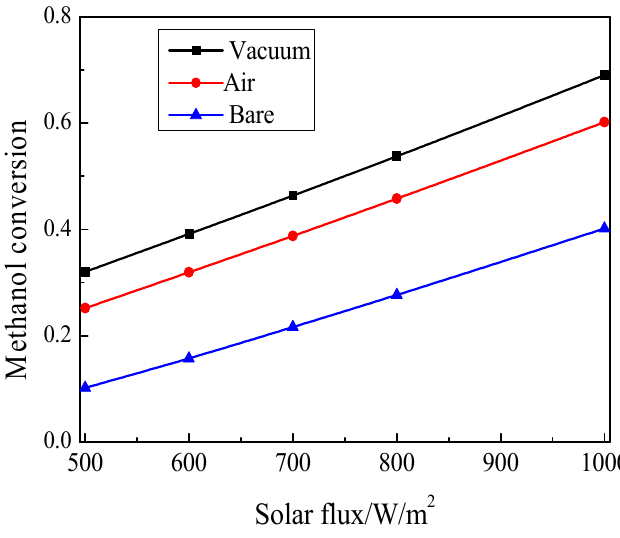
Figure 8. Variation of methanol conversion with solar flux in three Fig. 8.Variation of methanol conversion with solar flux in three configurations 273